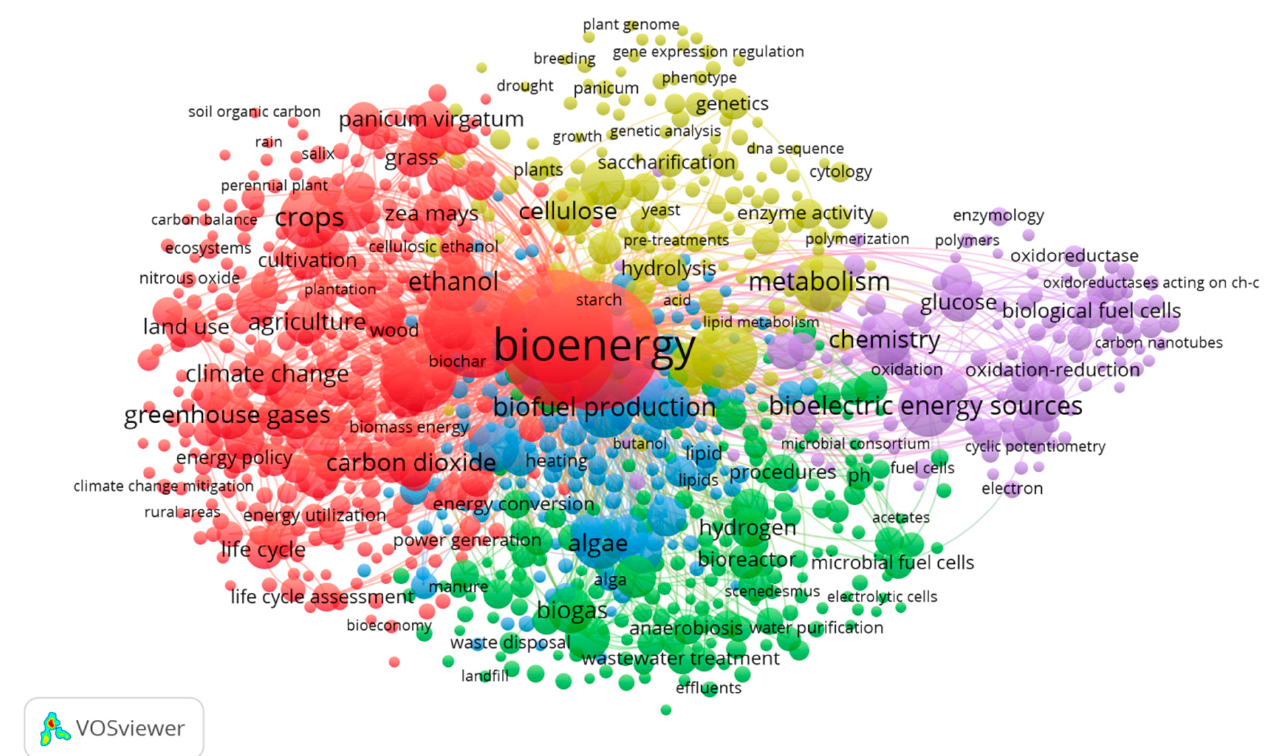
Figure 5. Results of bibliometric analysis of co-occurrence keywords on the request “bioenergy” +